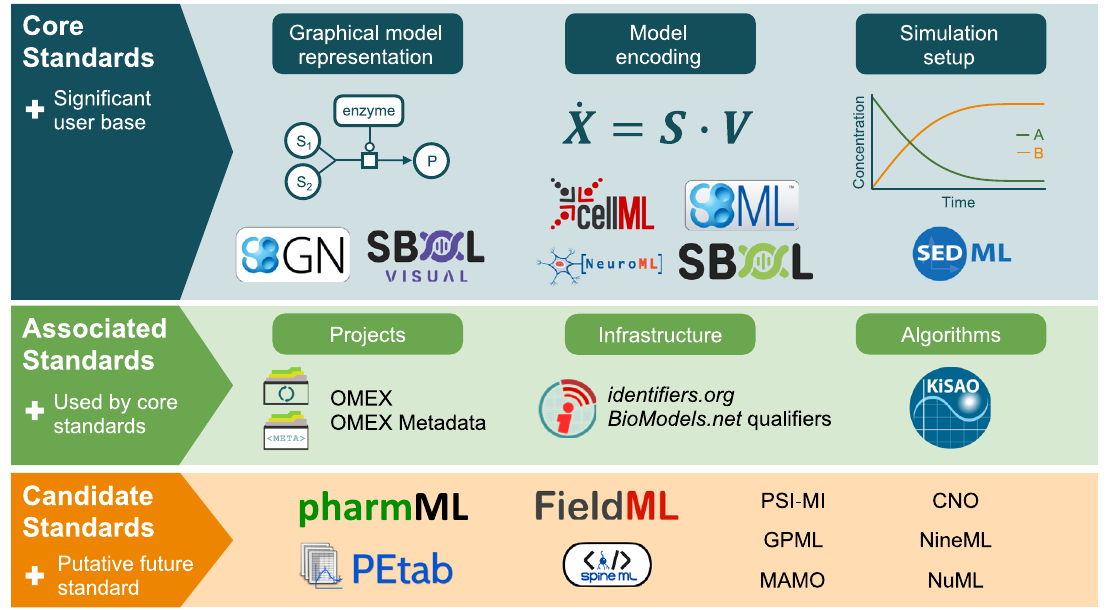
Figure 2: SBGN and other standards covered by COMBINE (from